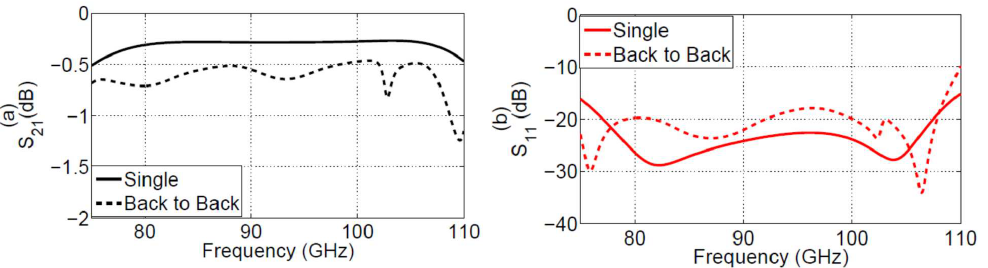
Figure 7. Predicted response of the first model of microstrip to standard WR-10 single (solid line) and back-to-back transitions (dashed line).